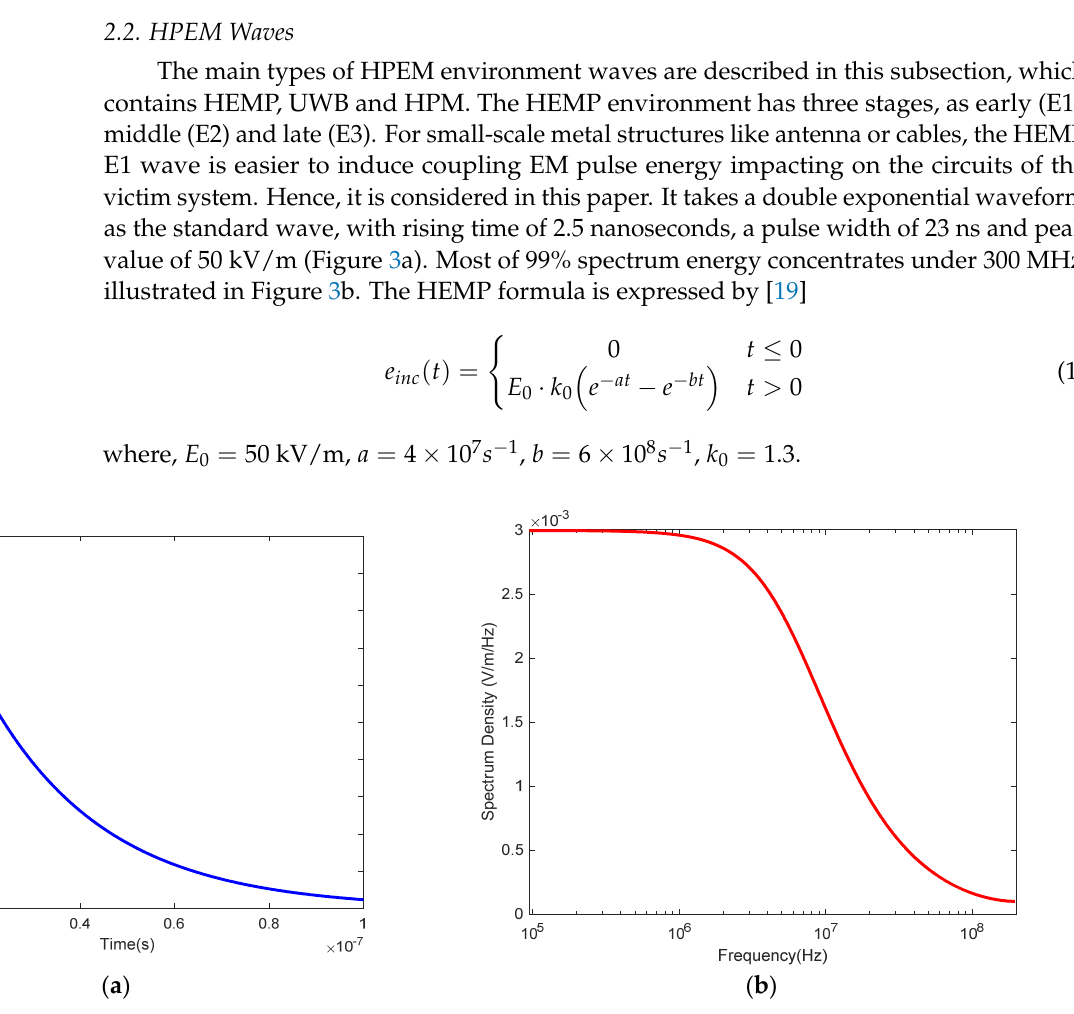
Figure 2. Wireless RF front-end circuits: ( a ) Pyramid horn antenna; ( b ) micro-strip band pass filter.